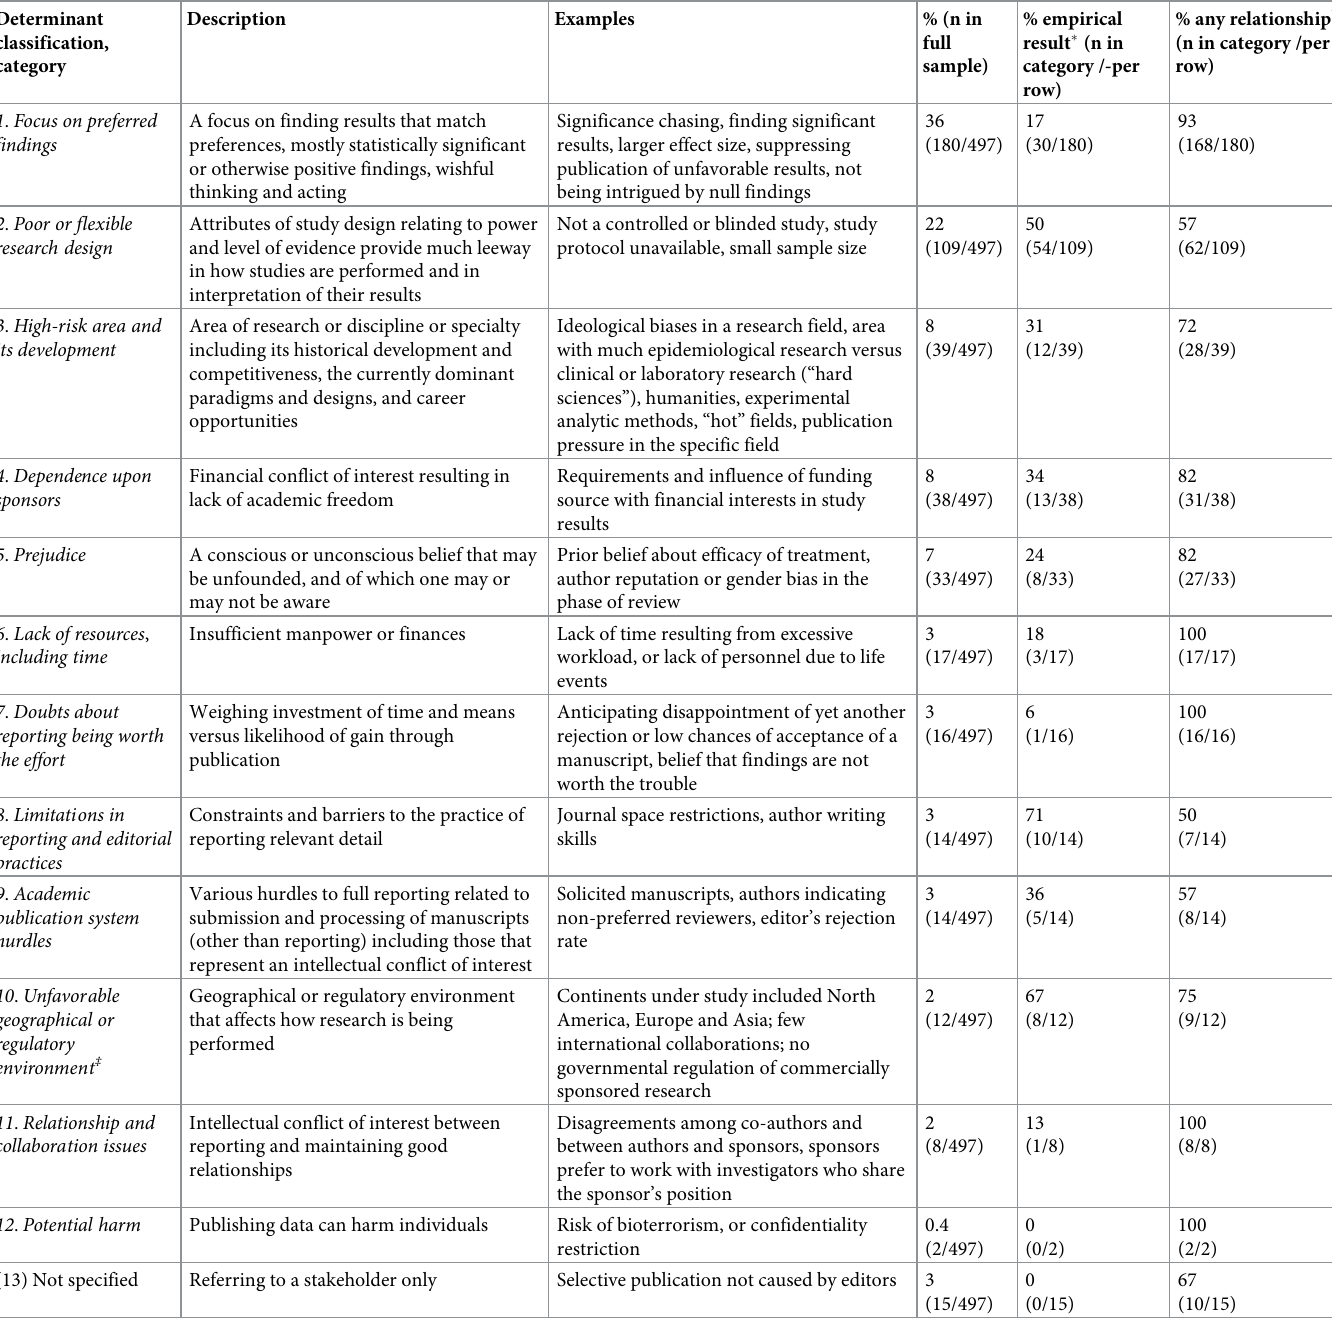
Table 3. Taxonomy of determinants (n = 497) resulting from the inductive qualitative content analyses. Determinant